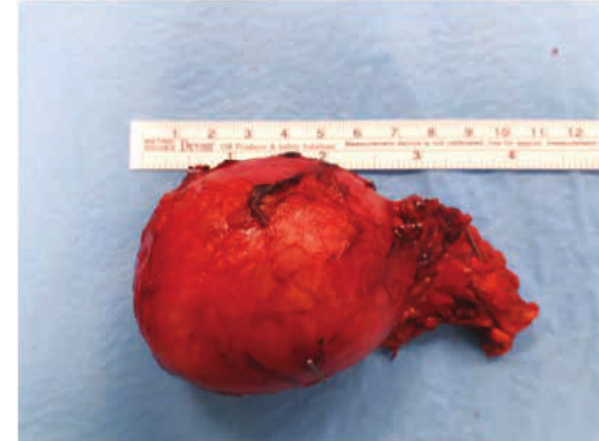
Figure 1: CT scan with suspected pancreatic tumor Figure 3: Excised tumor